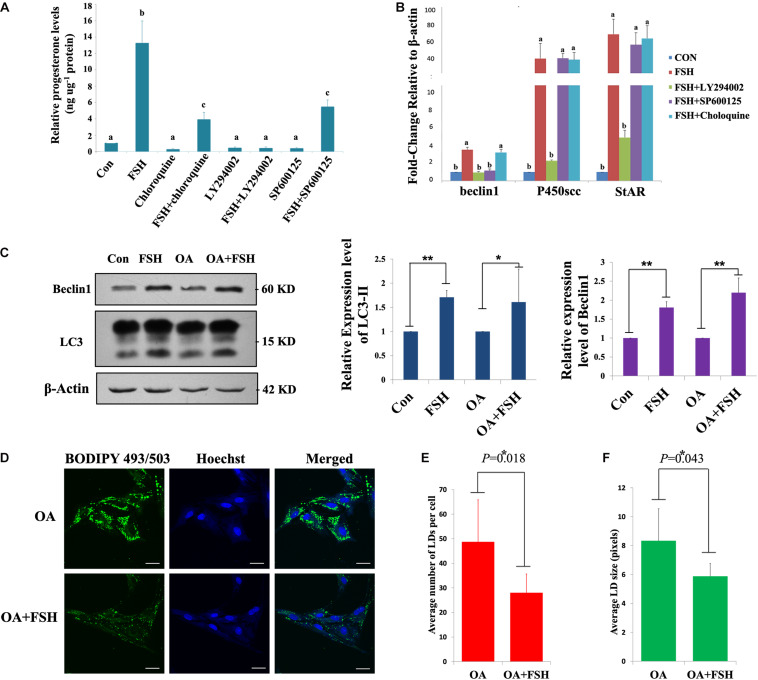
Autophagy participates in progesterone production and lipid droplet metabolism upon FSH treatment in porcine GC mass. (A) Specific inhibitors of autophagy (chloroquine; 10 μM), PI3K/AKT (LY294002; 10 μM), and SAPK/JNK (SP600125; 10 μM) were added 1 h before treatment with 0.01 IU/mL FSH for 24 h in GC mass. The cells and culture medium were collected separately. The total proteins were extracted from the cells and quantified using the BCA method. The concentration of progesterone in the culture medium was analyzed using radioimmunoassay. The relative progesterone level in the culture medium was calculated as ng/μg protein. Different superscripts (a, b, c) indicate significant differences (P < 0.05) (B) Specific inhibitors of autophagy (chloroquine; 10 μM), PI3K/AKT (LY294002; 10 μM), and SAPK/JNK (SP600125; 10 μM) were added 1 h before treatment with 0.01 IU/ml FSH for 24 h in GC mass. Total RNA was extracted from the cells, reverse transcribed to cDNA, and analyzed by real-time PCR with primers against beclin1, StAR, and P450scc. (C) Adherent granulosa cells of the porcine ovary were cultured in DMEM/F12 serum-free medium with or without oleic acid (0.5 mM) for 12 h, and then cultured in DMEM/F12 serum-free medium with FSH (0.01 IU/mL) or with FSH and OA (0.5 mM) for 24 h. β-actin, LC3-II, and Beclin 1 levels were detected by western blotting. (D) BODIPY 493/503 LD staining of adherent granulosa cells after treatment with OA and FSH; Hoechst 33342 staining of the cell nuclei, Bars: 30 μm. (E) The average number of LDs per granulosa cell in the OA and OA + FSH groups. (F) The average size of LDs per granulosa cell in the OA and OA + FSH groups. Five visual regions were used for statistics. ∗, P < 0.05, ∗∗, P < 0.01.